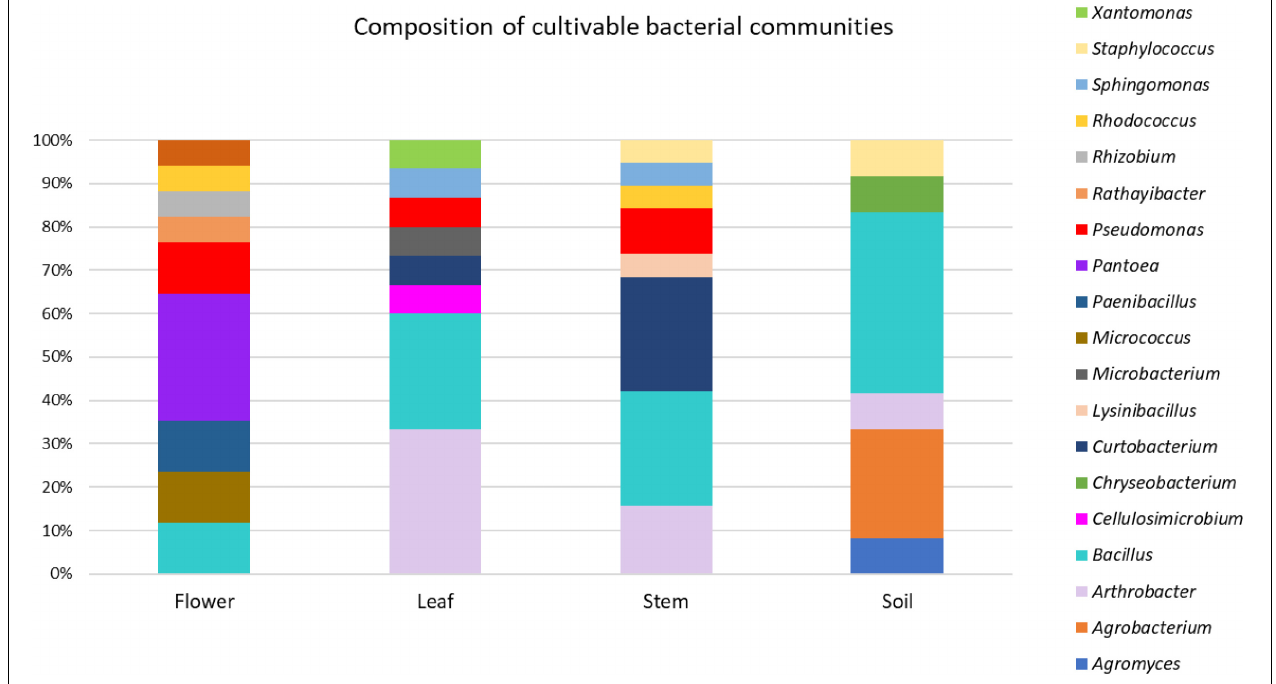
FIGURE 2 | Composition of cultivable bacterial communities of O. vulgare . Number of genera for each district: flower (8), leaf (8), stem (8), soil